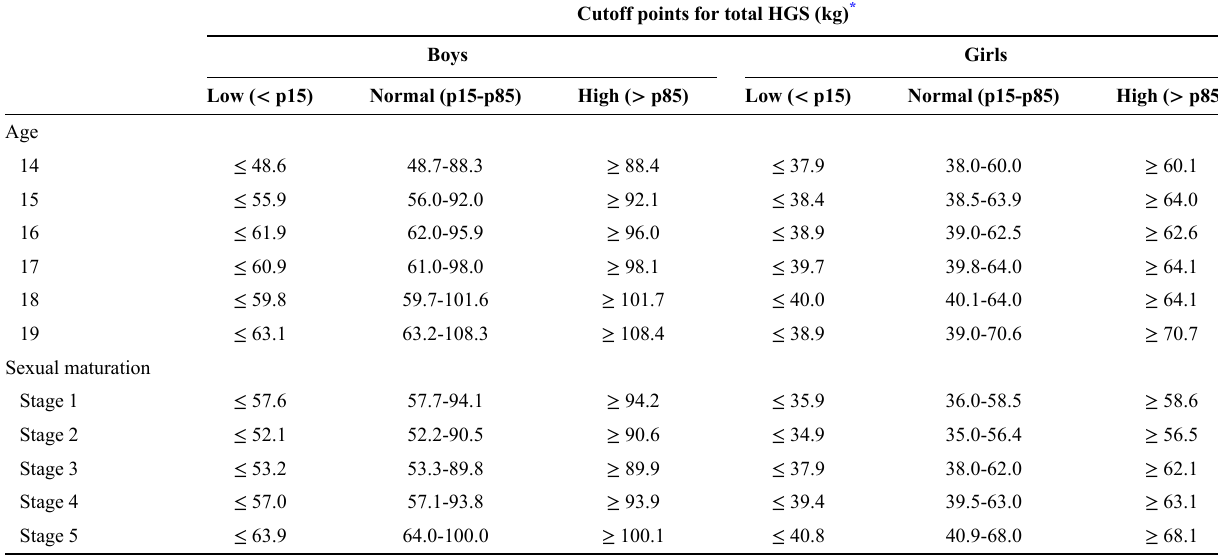
Table 4 - Cutoff points for total HGS, based on the participants in the present